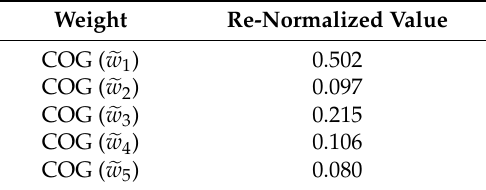
Table 4. The re-normalization results.